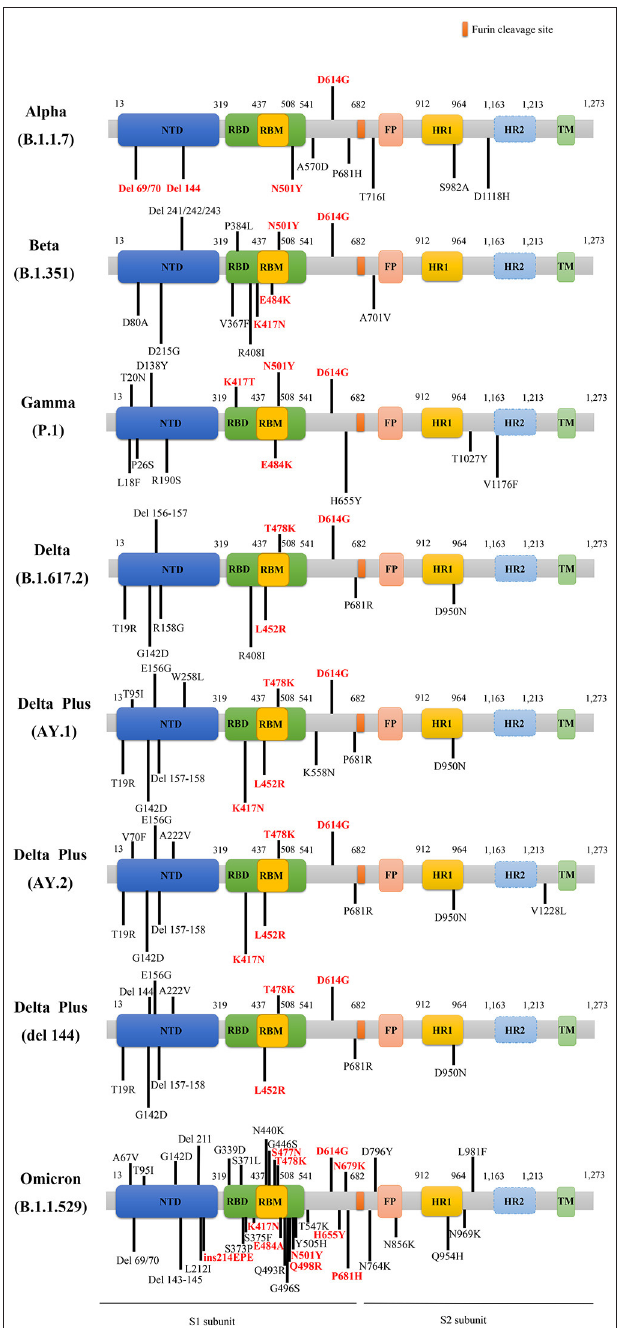
FIGURE 2 | The schematic diagram of the corresponding mutation sites of predominant variants in S protein. The red D614G mutation is shared by these main variants. The rest of the mutations labeled red belong to key mutations in the respective variants. NTD, N-terminal domain; RBD, receptor binding domain; RBM, receptor-binding motif; FP, fusion peptide; HR1, heptad repeat 1; HR2, heptad repeat 2; TM, transmembrane region; del, deletion; ins,